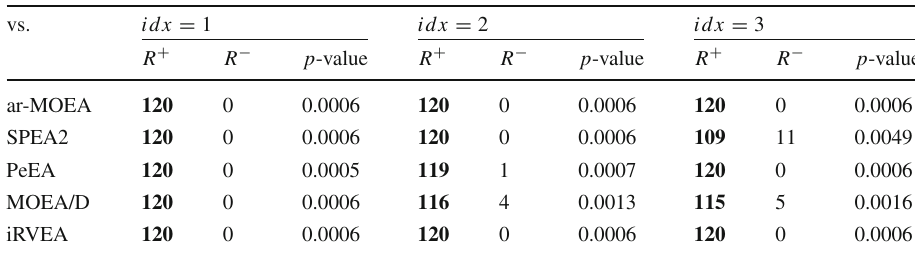
Table 4 Wilcoxon rank test between ˆga-NSCSA and other compared